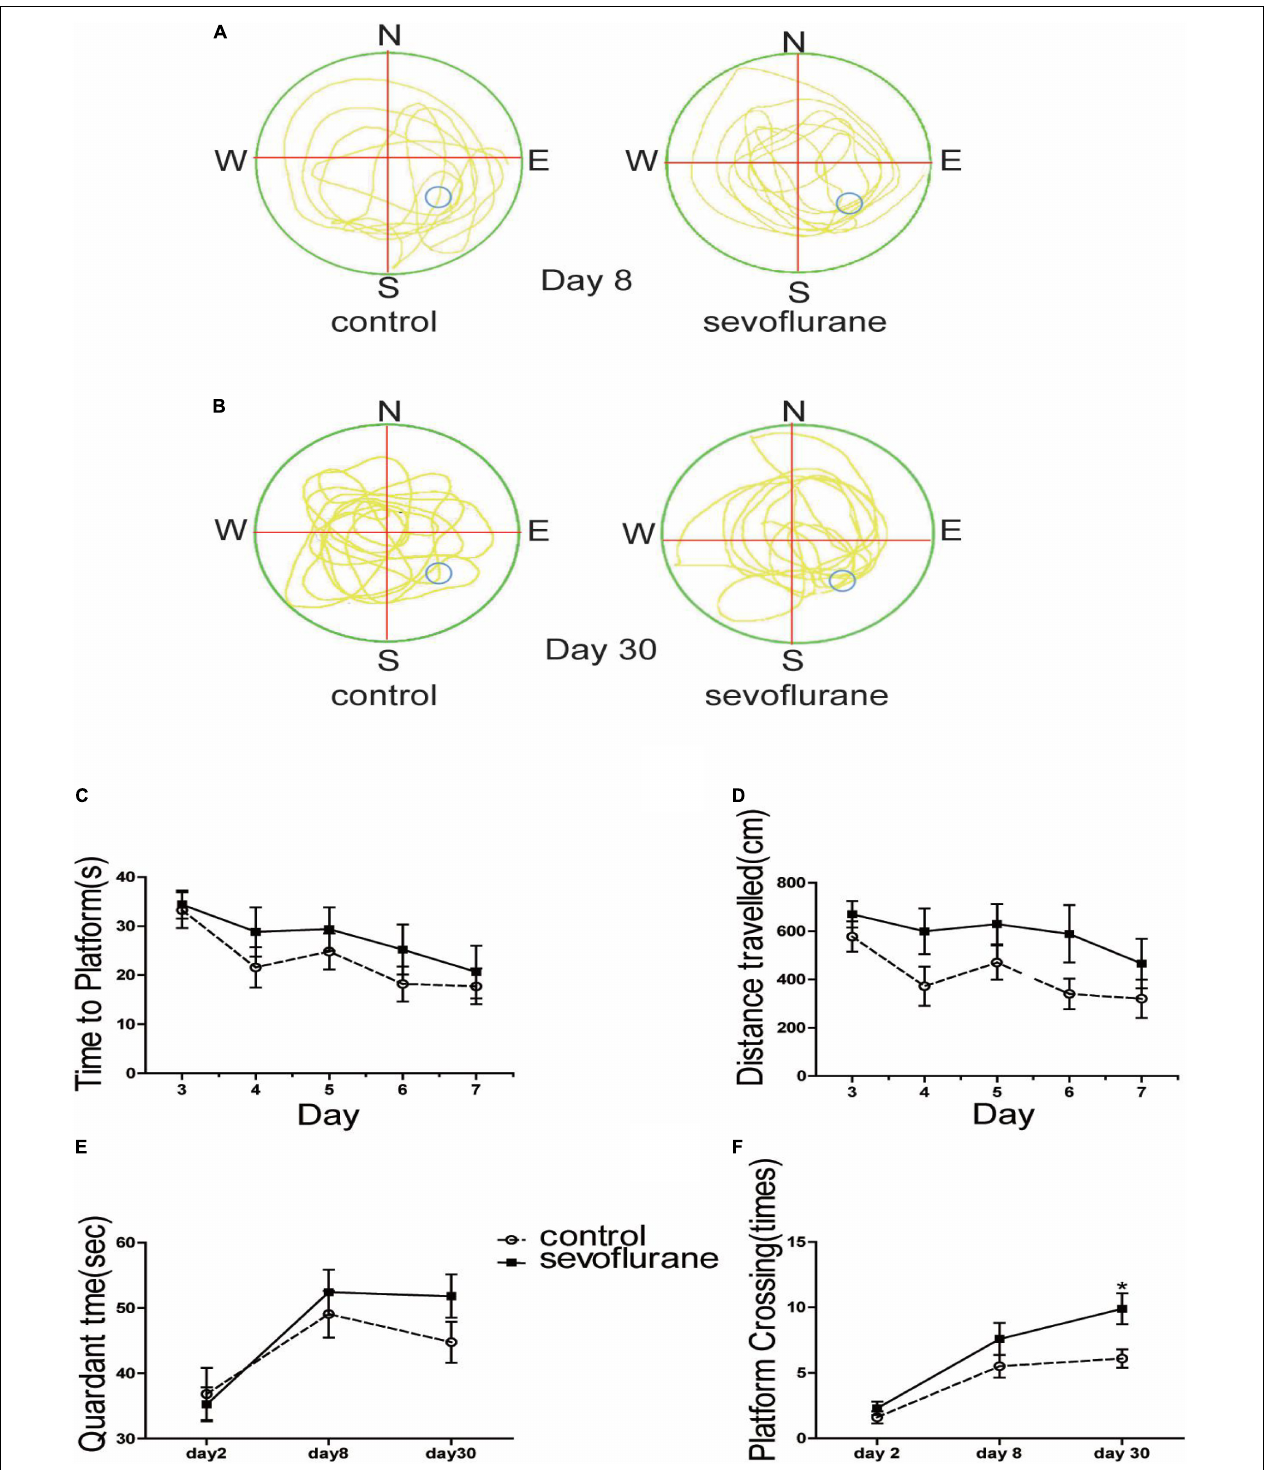
FIGURE 2 | Sevoflurane exposure changed spatial memory in the water maze test. Seven-day-old pups were exposed to 3% sevoflurane for 4 h and then allowed to grow up to 2 months. They were then subjected to the water maze test. (A) The trajectory path of day 8; (B) the trajectory path of day 30; (C) time spent to locate the platform during the 5-day course of the test after the 1st day for acclimatization and 2-day training; (D) the distance of swimming path; (E) the time spent in the platform region; and (F) the platform crossing times. Data are presented as mean ± SEM ( n = 10). * P < 0.05.